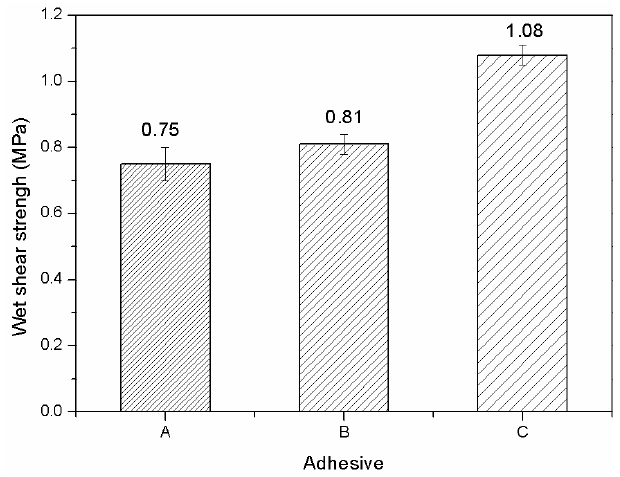
Figure 5. The wet shear strength of the adhesive: (A) MSM adhesive, (B) MSM/NCC adhesive, and (C) MSM/MNCC adhesive.